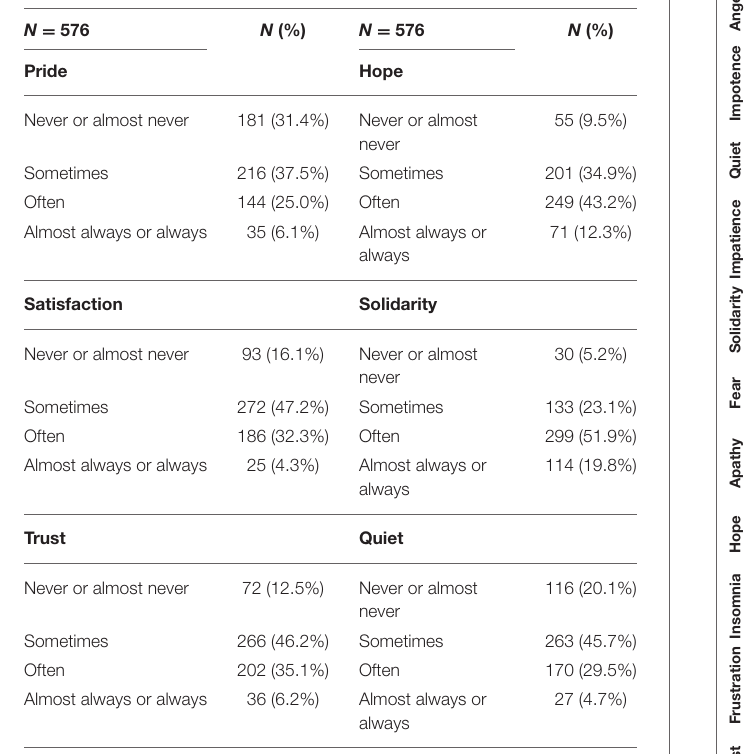
TABLE 3 | Self-reported prevalence of positive